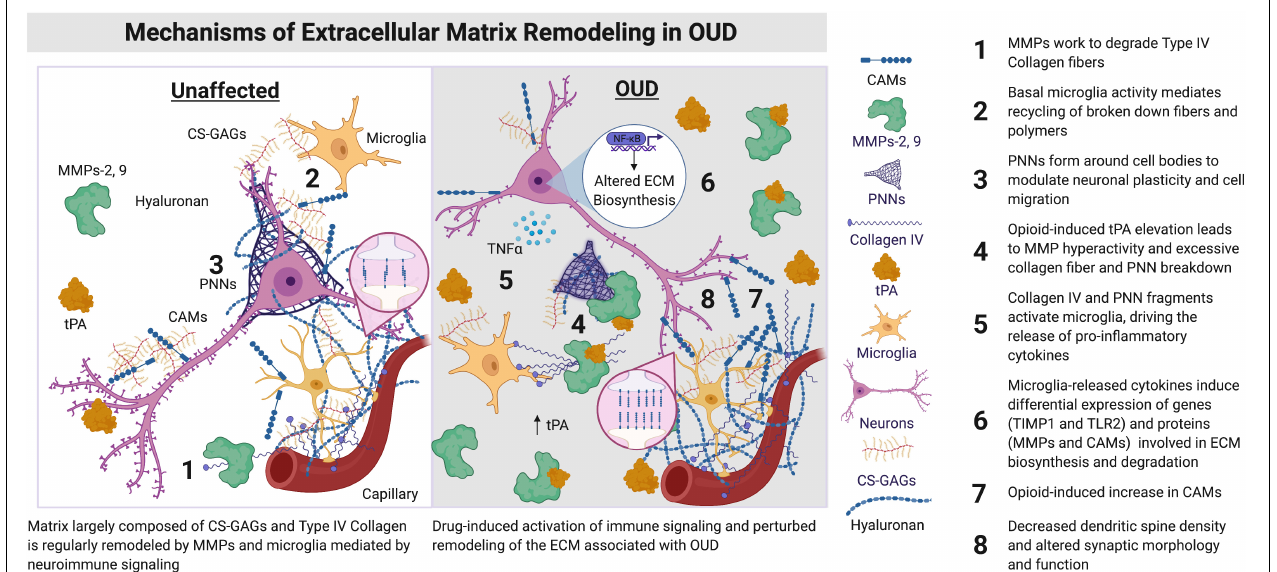
FIGURE 1 | Synaptic morphology and function are regulated by ECM signaling proteins and microglia. The components of the ECM lie proximal to brain capillaries and vessels, condensed as PNNs around cell bodies, including neurons, astrocytes, and microglia, along with synapses and dendrites of neurons. ECM components are also distributed amongst cells of the brain within the parenchyma. Hyaluronan is primarily located in the neural interstitial matrix of the parenchyma. Hyaluronan is involved in the regulation of inflammation and myelination in the brain, including remyelination after insult or injury. Opioids lead to an increase in neuroimmune activation by microglia and other immune cell types in the brain. An induction of immune activation in the brain can lead to increased expression and activity of tPAs, MMPs, CAMs, and Collagen IV (Webersinke et al., 1992; Roberts et al., 2018). Augmented activity of these ECM signaling proteins remodels the ECM, with consequences on dendritic spine morphology, including the reduction of spine number in key regions associated with OUD (e.g., prefrontal cortex and nucleus accumbens). CAMs, cell adhesion molecules; CS-GAGs, chondroitin sulfate glycosaminoglycans; ECM, extracellular matrix; MMPs, matrix metalloproteinases; NF- κ B, nuclear factor kappa B; OUD, opioid use disorder; PNNs, perineuronal nets; TIMP, tissue inhibitor of metalloprotease; TIMP1, TIMP metallopeptidase inhibitor 1; TLR2, toll-like receptor 2; tPA, type plasminogen activator. Figure created using